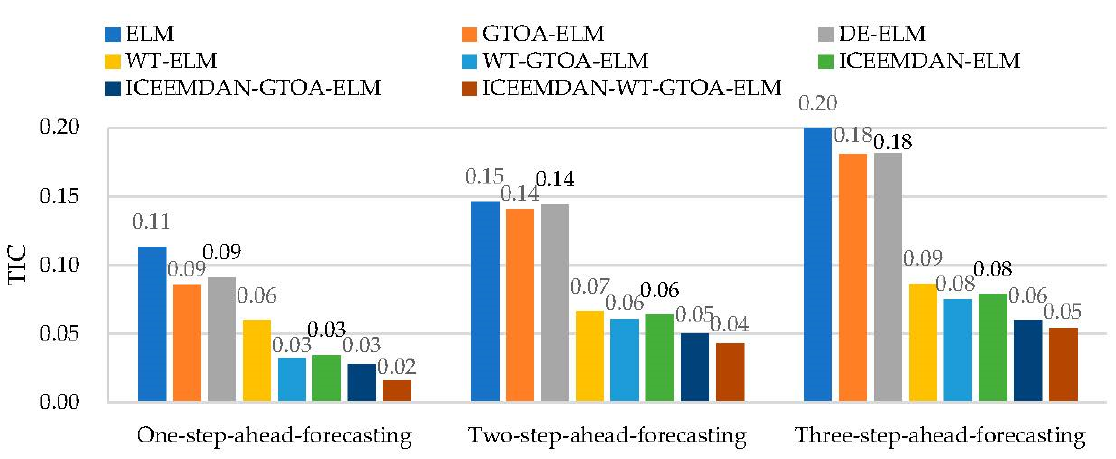
Figure 7. Theil’s coefficient (TIC) of PM10 forecasting.